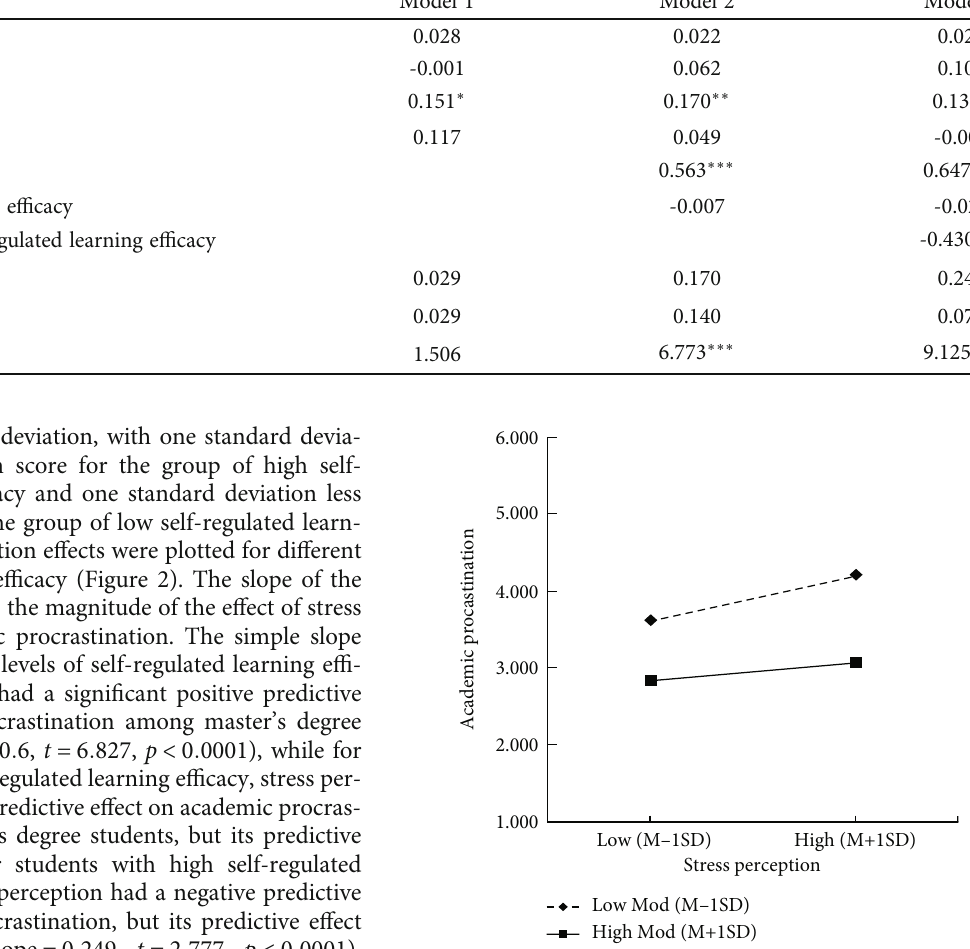
Figure 2: The moderating e ff ect of self-regulated learning e ffi cacy on stress perception and academic